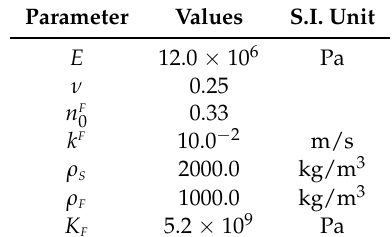
Table 2. Material parameters for the 3D model.